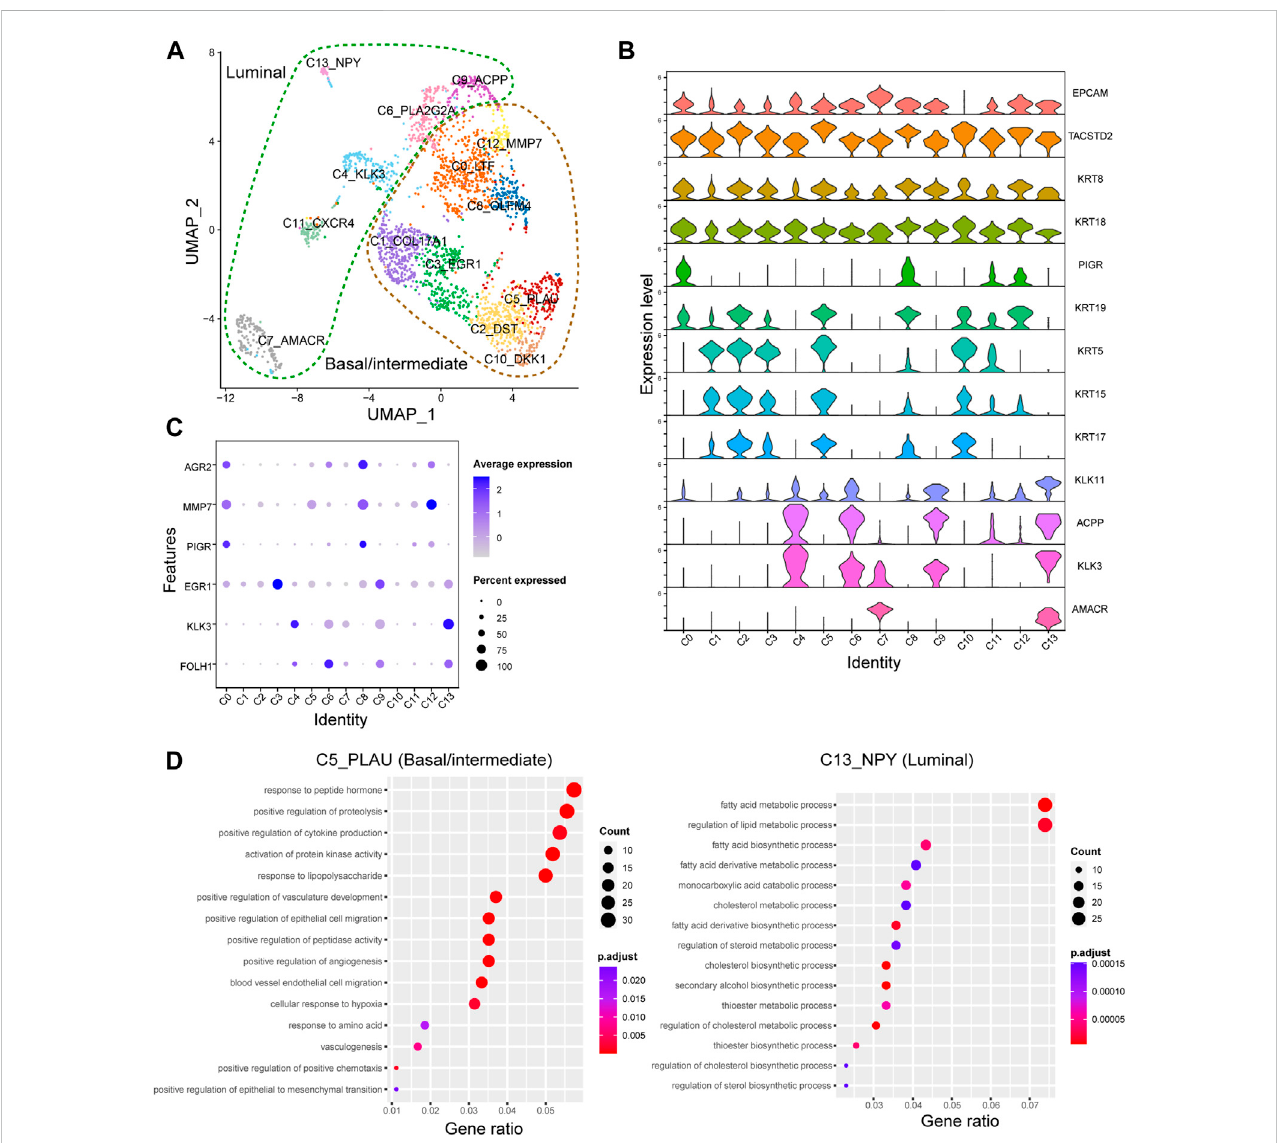
FIGURE 2 The epithelial cell type classi fi cations in PNI-PCa tumor tissue. (A) Epithelial cells are divided into 13 different subgroups, UMAP of epithelial cells annotated bycell types. (B) Violin plots of marker genes across the epithelial cell subtypes. (C) The relative expression of FOLH1 , KLK3 , EGR1 , PIGR , AGR2, and MMP7 genes in different epithelial subgroups. (D) GO enrichment analysis for DEGs in basal/intermediate cell subtype C5 and luminal cell subtype C13,